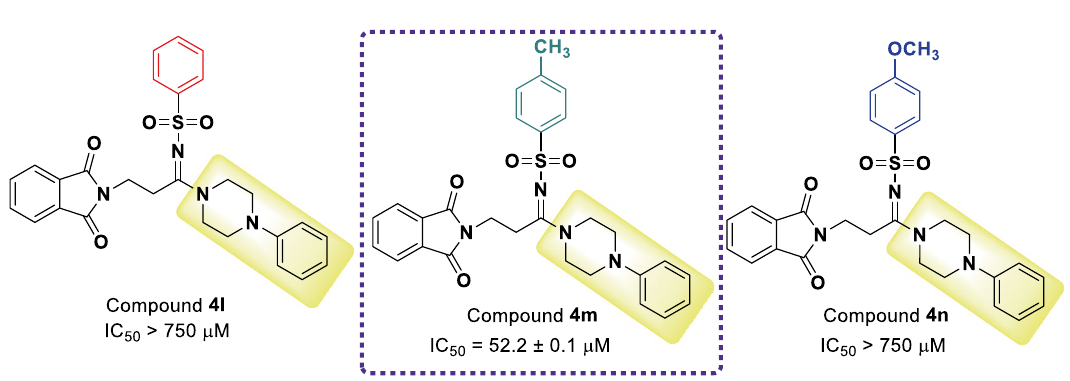
Figure 5. Comparison of α-glucosidase inhibitory activities of analogs 4l – n (ChemDraw